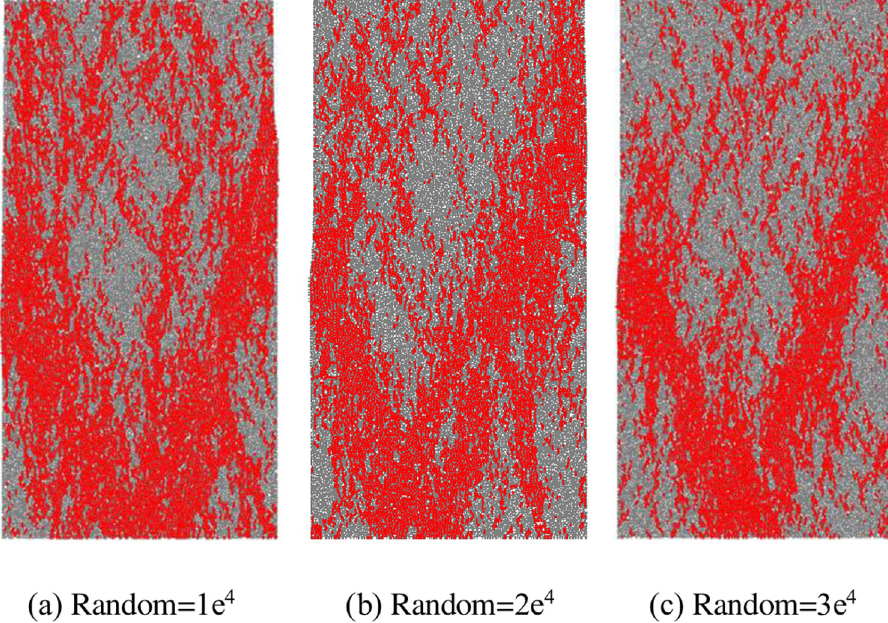
Fig 4. Failure modes of the intact model under different random seeds. (a) Random = 1e4, (b) Random = 2e4, (c) Random = 3e4. https://doi.org/10.1371/journal.pone.0275626.g004 (by 1.81 MPa and 0.14 GPa, respectively). This indicates that even with relatively small defect sizes, there is still a degrading effect on the mechanical properties of the rock sample. With the increase in the circular defect’s diameter, the peak stress and elastic modulus of the rock sam- ples decrease significantly. The peak stresses at the defect sizes of 1/10, 1/5, 3/10, 2/5, and 1/2 of the bottom diameter of the rock sample are 112.68 MPa, 100.14 MPa, 84.68 MPa, 68.01 MPa, and 52.67 MPa, respectively, and the elastic moduli are 76.04 GPa, 72.80 GPa, 66.68 GPa, 58.45 GPa, and 49.09 GPa, respectively. The UCS and elastic modulus show a gradual down- ward trend. Compared with the intact model, when the defect size reaches half of the rock sample’s bottom diameter, the UCS and elastic modulus decrease by 57.88% and 36.34%, respectively. Fig 6(A) shows that the peak strain of each model is gradually reduced as the defect size gradually increases. This indicates that the larger the defect size, the progressively lower the amount of deformation the rock samples can withstand, so the rock sample is dam- aged earlier.